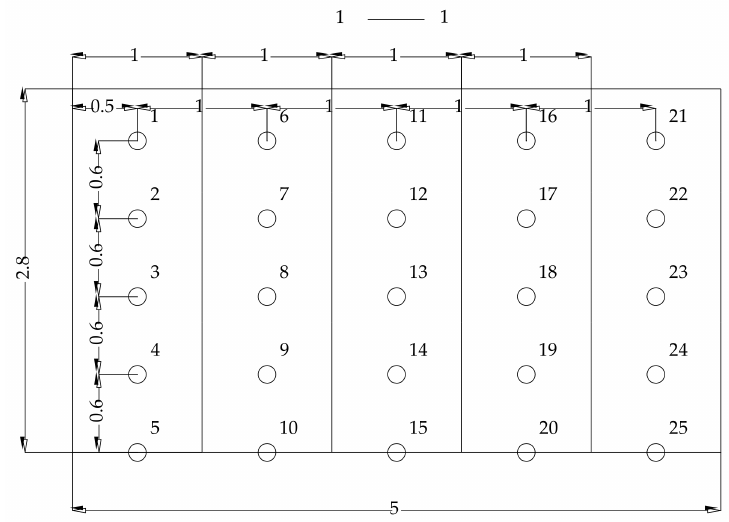
Figure 7. The vertical distribution diagram of the experimental test